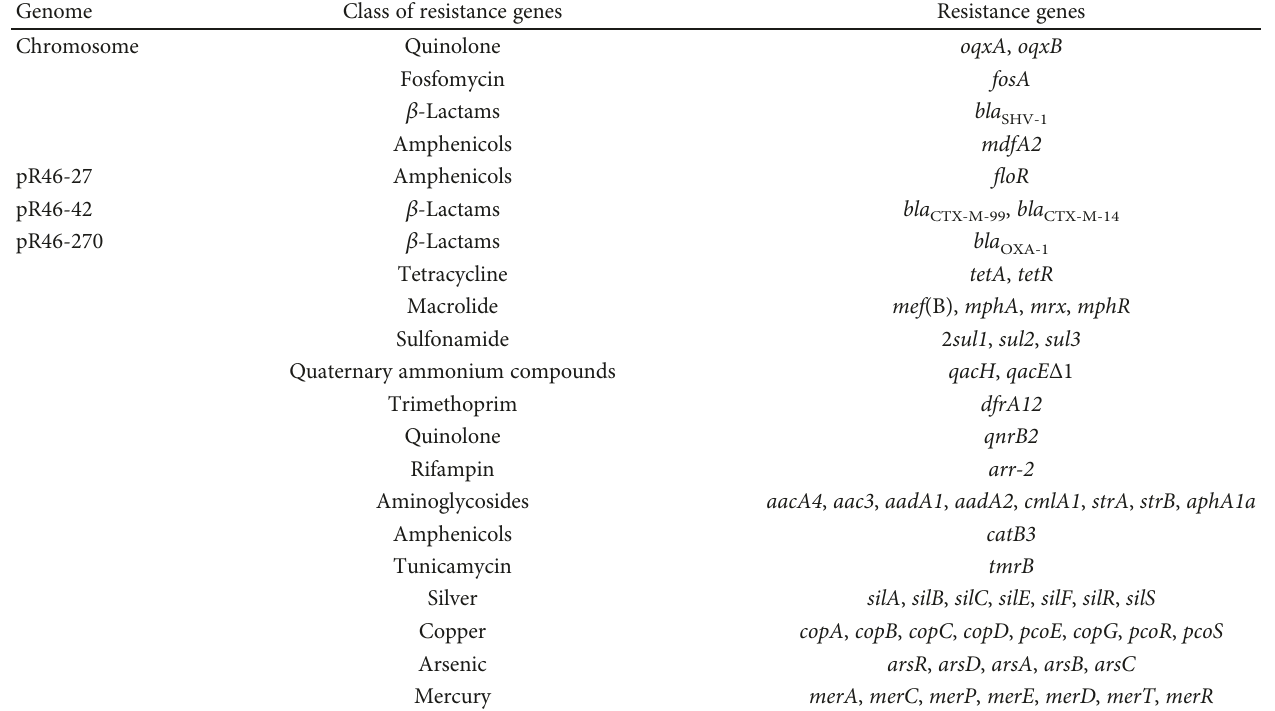
Table 4: Resistance genes encoded on the K. pneumoniae R46